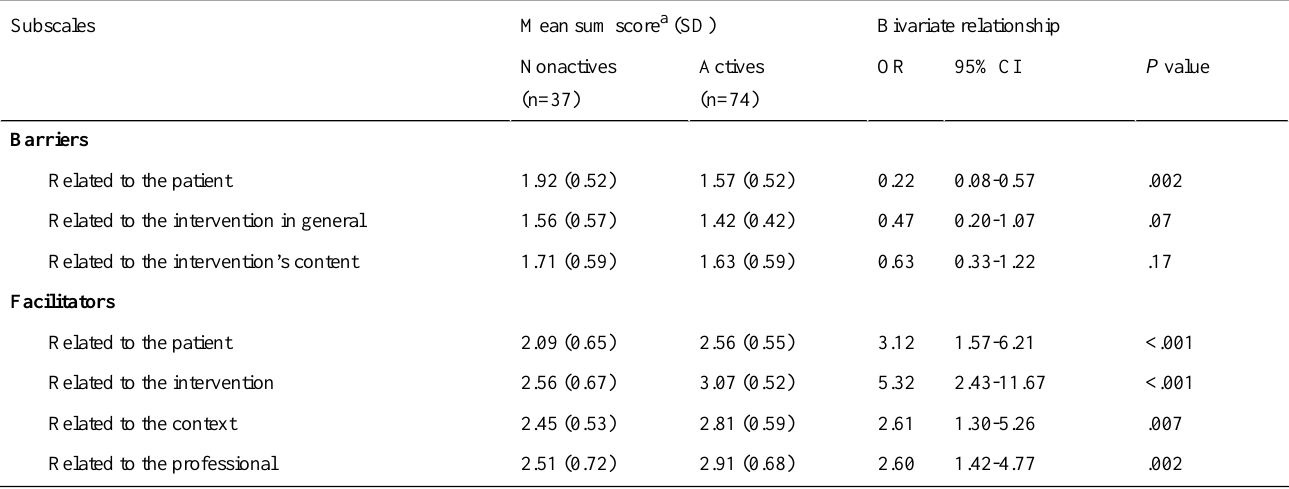
Table 4. Means (range 1-4), standard deviations, and bivariate relationships of nonactive versus active users.